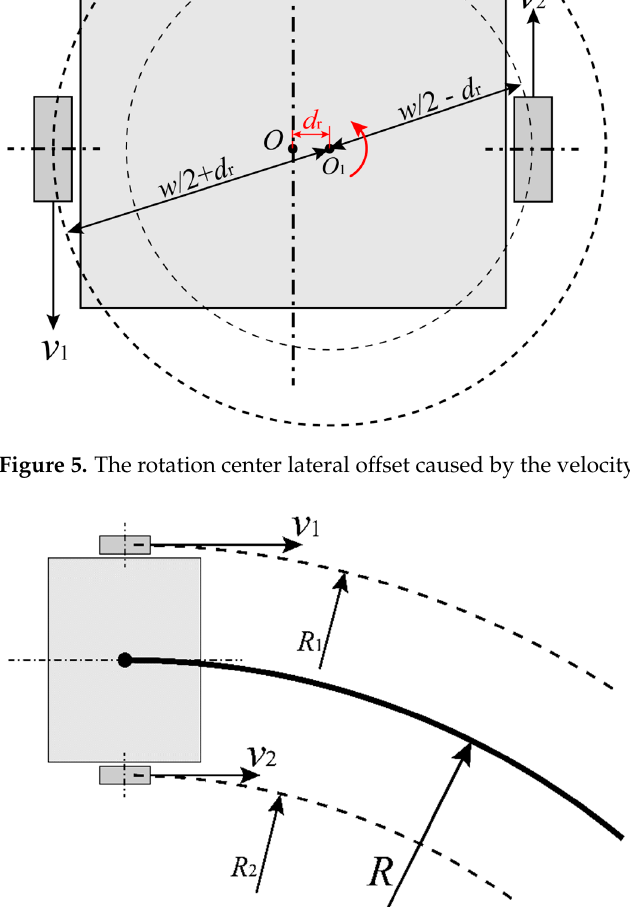
2 w d − . The angular velocities of the two wheels are the same. r